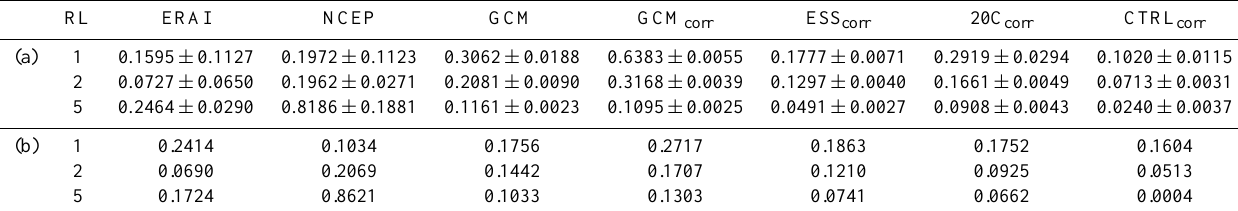
Table 3. 9 values for the different data sets: (a) calculated with Eq. (9) and with the information of the confidence interval (b) computed − 1, RL: Return with ψ = Var (X) E (X)